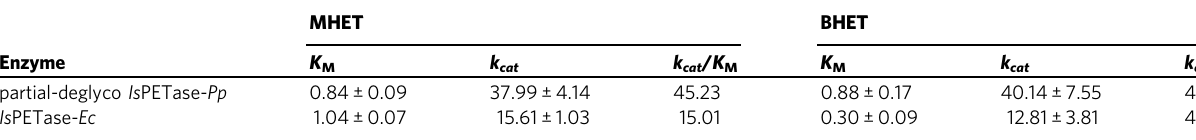
Table 2 Is PETase kinetics for MHET and